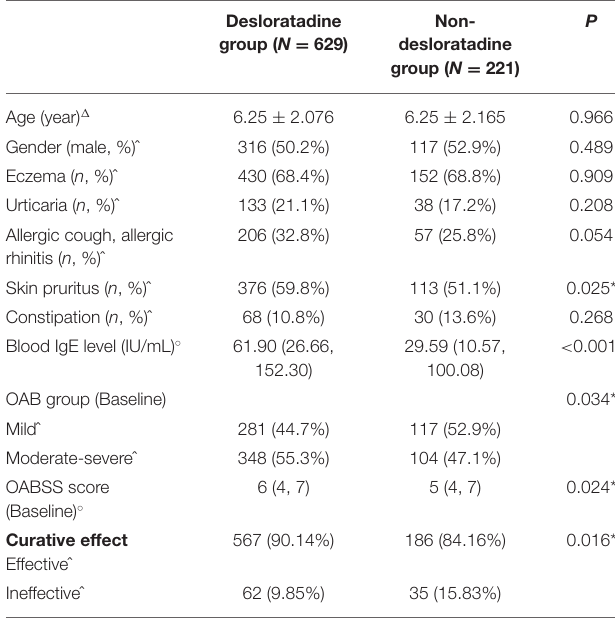
TABLE 6 | Logistic regression analysis of risk factors for ineffective treatment of OAB with desloratadine. OR 95% CI Gender (male, %)